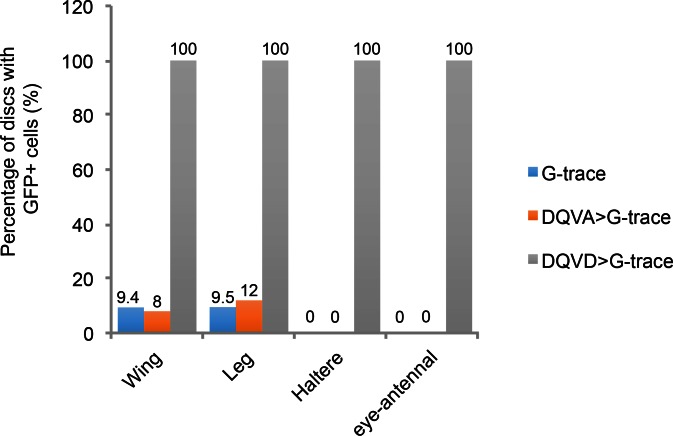
Comparison of GFP expression in the CasExpress DQVD sensor, the DQVA control or G-trace alone.The percentage of wing, leg, haltere and eye-antennal discs containing GFP-expressing cells for the G-Trace alone (blue bars), G-Trace together with the DQVA caspase-insensitive control (orange bars), or G-Trace together with the DQVD caspase sensor (gray bars) are shown.